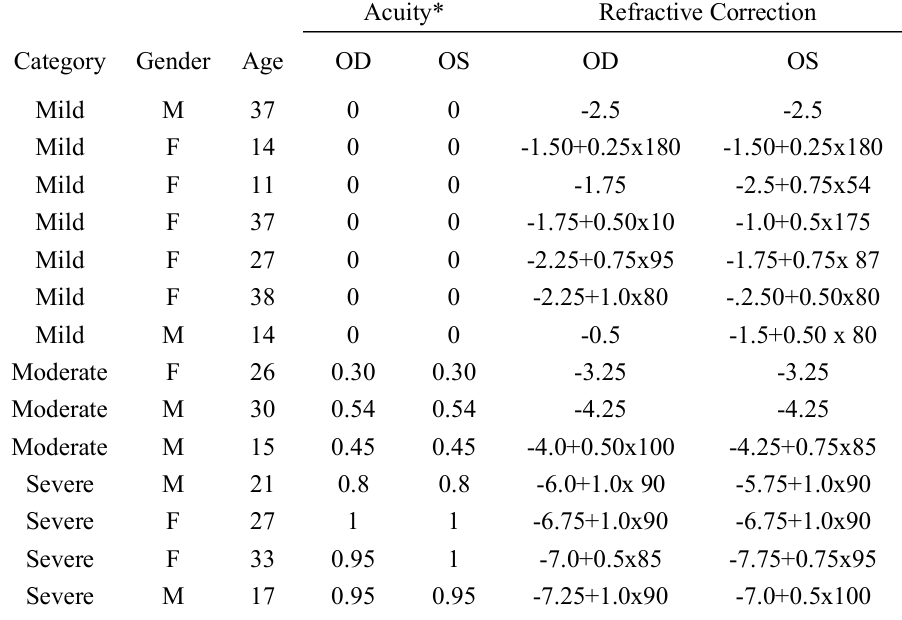
Table 1: Clinical characteristics and demographics of study